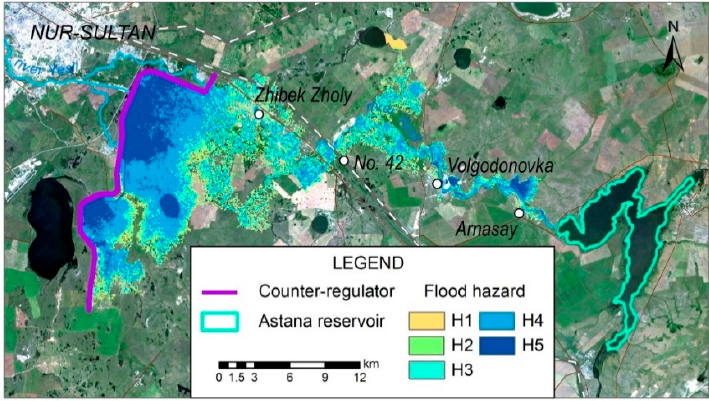
Figure 7. Hazard map (Classification 1) produced from the 100-year return period flow hydrograph.